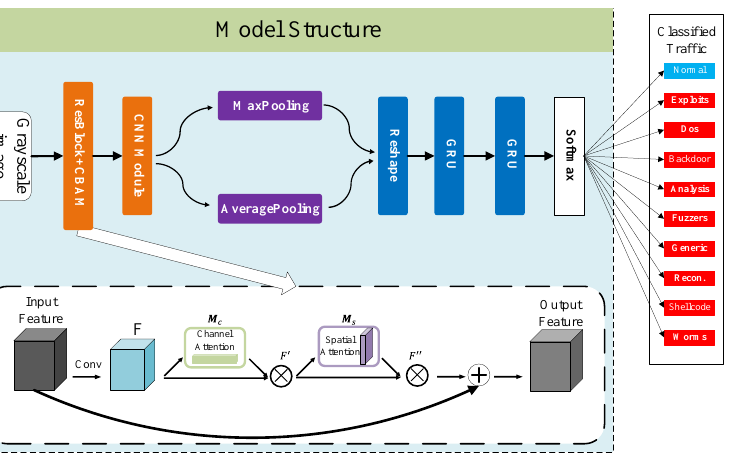
Figure 7. Intrusion detection model structure diagram. ⊗ denotes element-wise multiplication and ⊕ denotes feature concatenate.